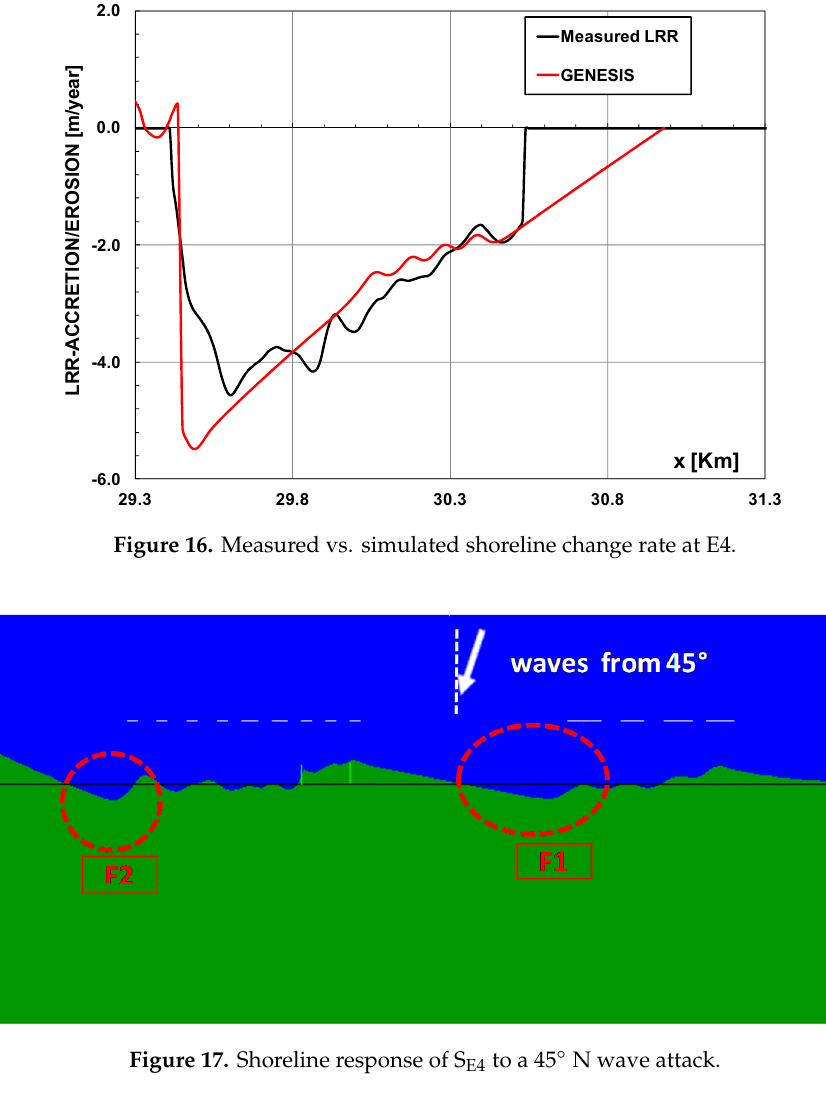
Figure 17. Shoreline response of S E4 to a 45° N wave attack.